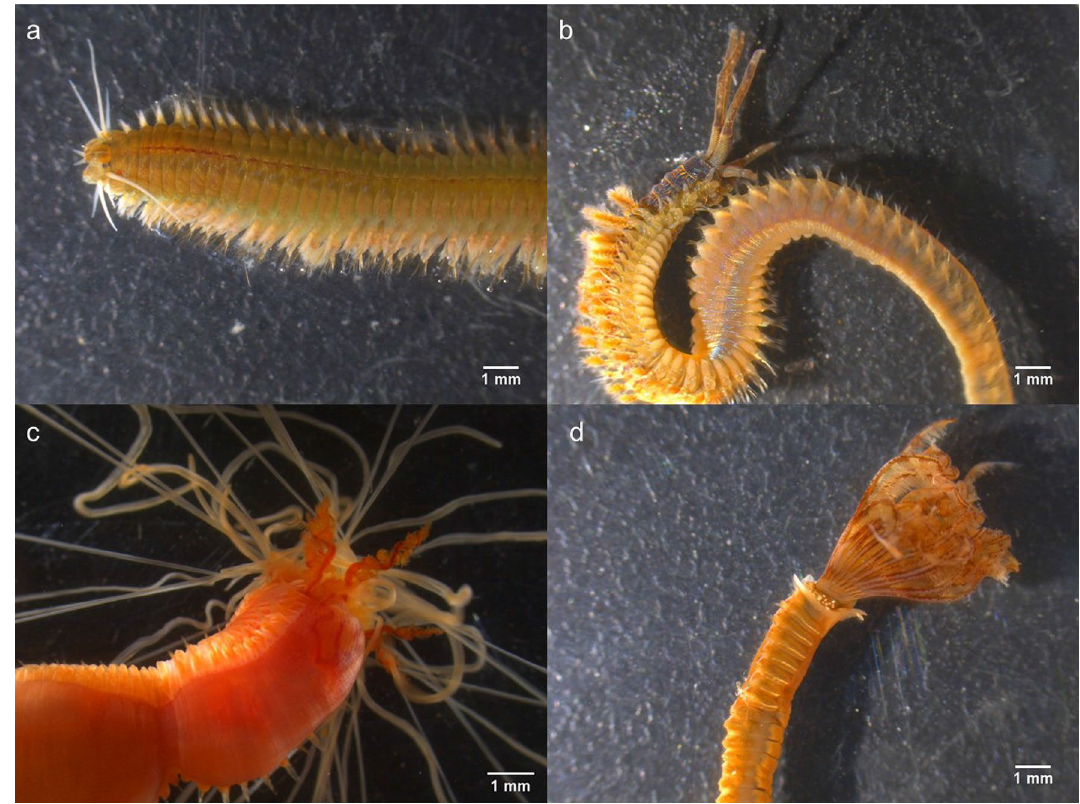
Figure 2. Polychaete species surveyed during the present study: ( a ) Hediste diversicolor ; ( b ) Diopatra neapolitana ; ( c ) Sabella cf . pavonina and ( d ) Terebella lapidaria .